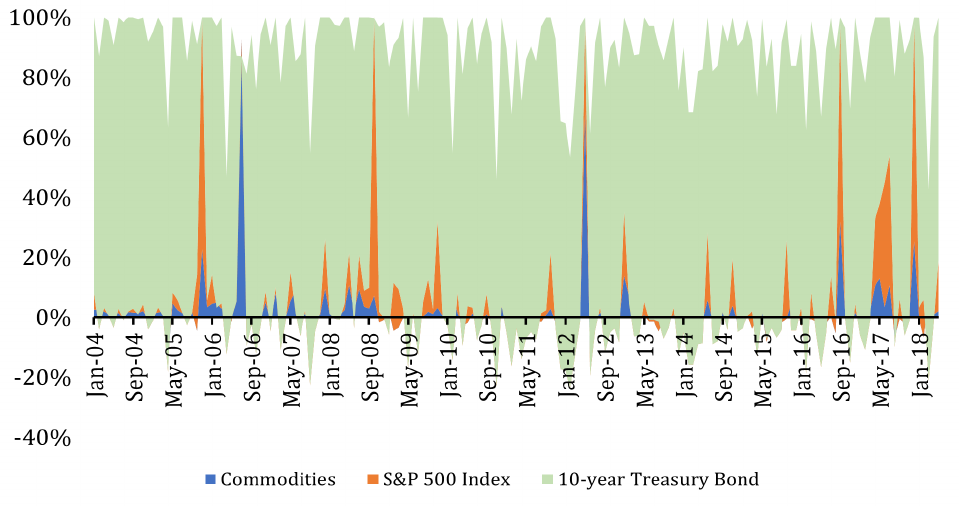
Figure 2. The graphs shows the optimal weights for an investor with γ = 0.1 under a simple AR(1) model (with transaction costs). The plot features a difference between 100%, and the sum of the colored areas (in white) represents the investment in